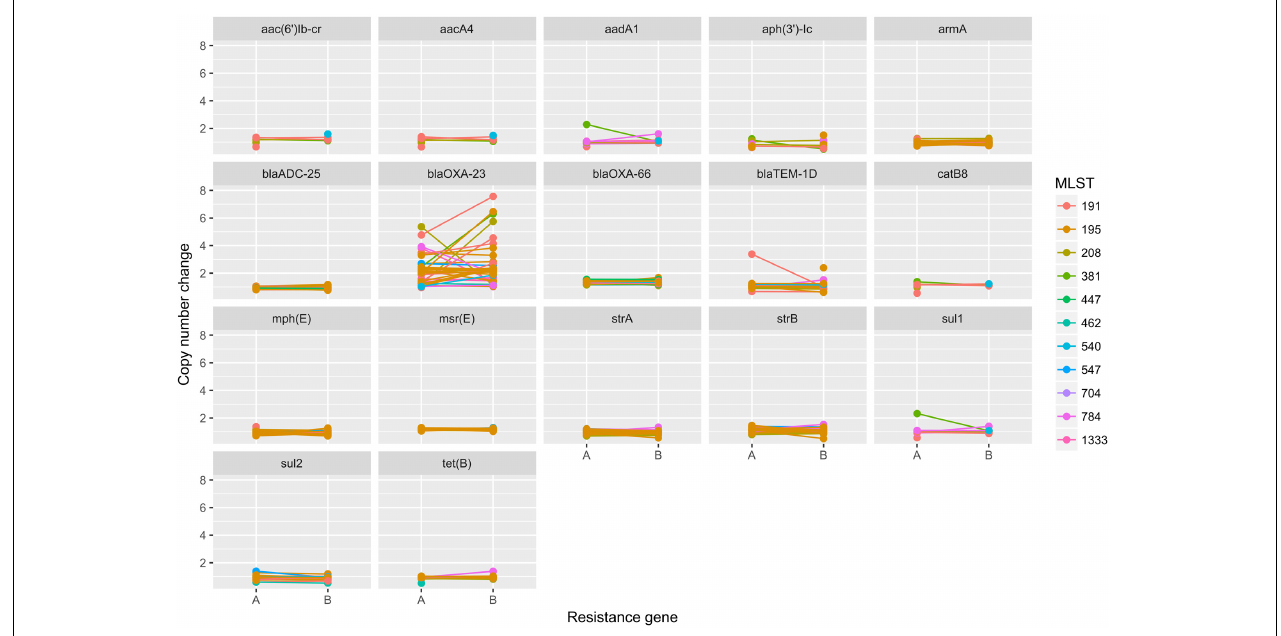
FIGURE 5 | The copy number change of resistance genes in Groups A and B in A. baumannii . The copy number of resistance genes were detected by cnv-seq via mapped the WGS data to the sequence of resistance